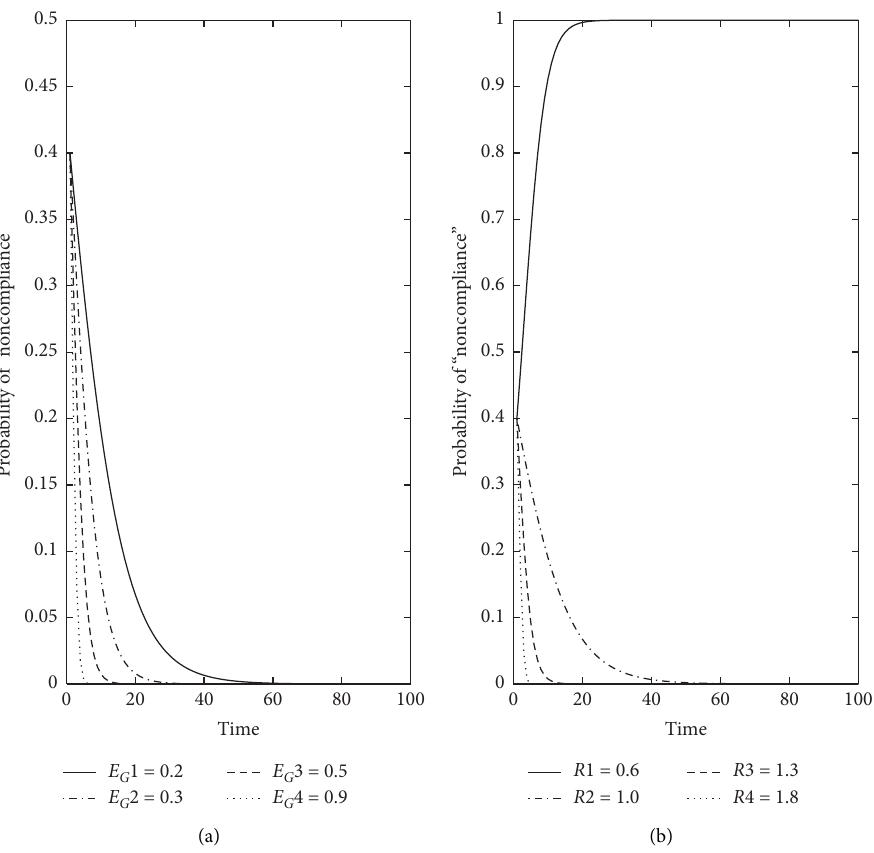
Figure 4: Evolutionary process of the entire system.